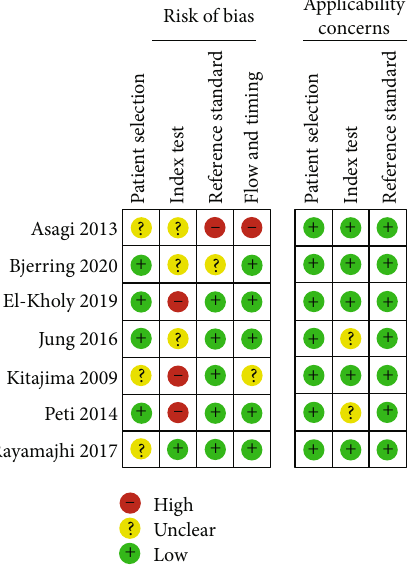
Figure 2: The listed studies ’ risk of bias & applicability problems are summarized.